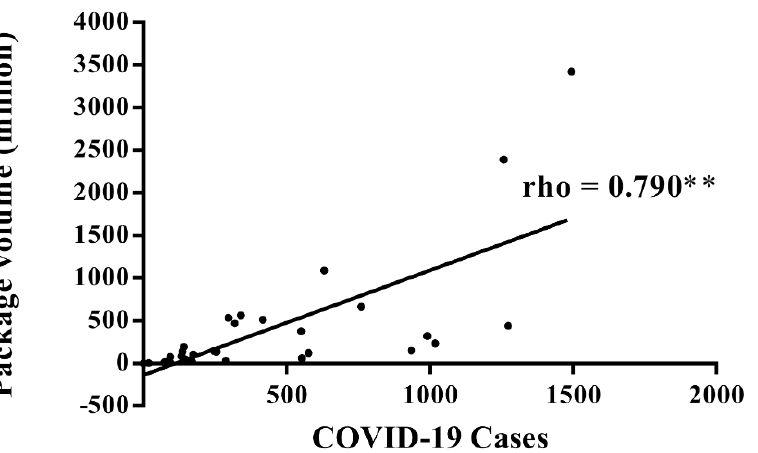
Figure 1. Correlation between the number of COVID-19 cases and the number of packages in the first quarter of 2000 for the 30 provinces or municipalities of China (except for Hubei province). ** represents p < 0.001.